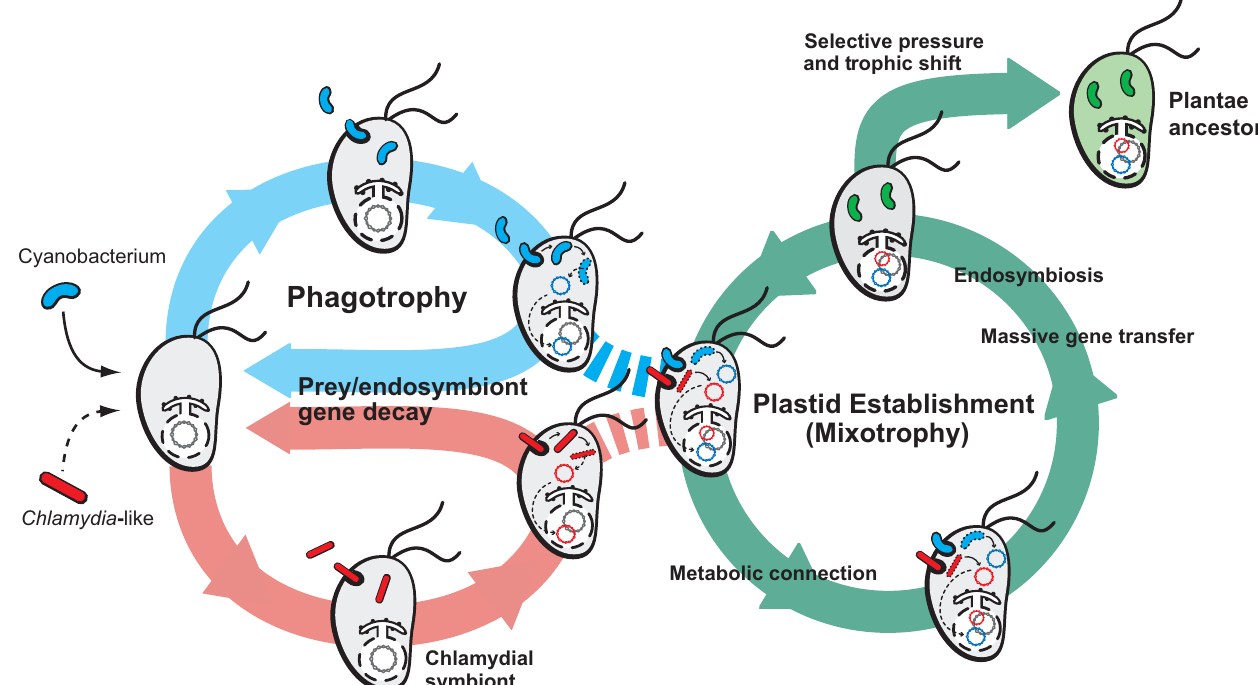
Figure 4. Mixotrophy hypothesis for the origin of the primary plastid in algae and plants. The ancestor of Plantae was a phagotrophic protist that consumed cyanobacteria as food and was parasitized by environmental Chlamydiae. Gene transfers from both prokaryotic sources to the host nucleus either resulted in their decay and loss or occasional gene replacement as observed in modern-day protists [25,43]. The transition to mixotrophy was facilitated by the transfer and activation of key genes from the cyanobacterium such as those that regulate the cell cycle. The mixotrophic Plantae ancestor continued to consume bacterial prey but over time, harvesting genes from Chlamydiae and eventually developed a regulated metabolic connection (e.g., for the export of fixed carbon compounds) between the newly established endosymbiont and the host cytosol [21] and a system for protein import into the endosymbiont using the host secretory system [11]. These developments cemented the relationship and led to selection for massive gene loss in the endosymbiont and EGT to the host nucleus. Activation of at least 37 genes recruited from Chlamydaie further enhanced plastid functions. The final transition occurred in a prey-poor environment that favored phototrophy. Thereafter this ancestral alga lost the ability for phagotrophy and diversified into the extant lineages of green, red, and glaucophyte